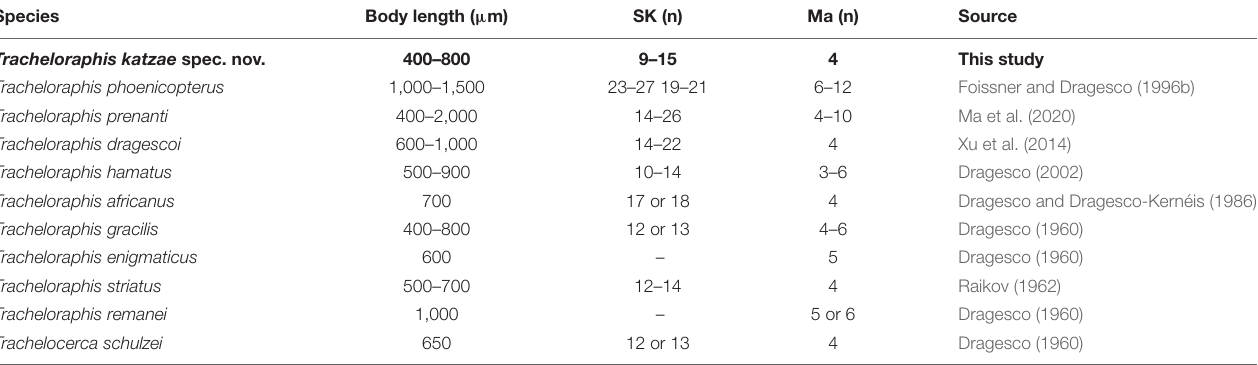
FIGURE 8 | (A–J) Selected Traceloraphis species that are morphologically similar to T. katzae spec. nov. A. Tracheloraphis prenanti (after Ma et al., 2020). B. T. dragescoi (after Xu et al., 2014). C. T. africanus (after Dragesco and Dragesco-Kernéis, 1986). D. T. striatus (after Raikov, 1962). E. T. remanei (after Dragesco, 1960). F. Trachelocerca schulzei (after Dragesco, 1960). G. T. phoenicopterus (after Foissner and Dragesco, 1996b). H. T. hamatus (after Dragesco, 2002). I. T. gracilis (after Dragesco, 1960). J. T. enigmaticus (after Dragesco, 1960). GS, glabrous stripe; Ma, macronuclei; Mi, micronuclei; NG, nuclear group. Scale bars = 200 µ m (A–C,E–J) ; 60 µ m (D) . TABLE 4 | Comparison of Tracheloraphis katzae spec. nov. (in bold) with morphologically similar congeners. Species Body length ( µ